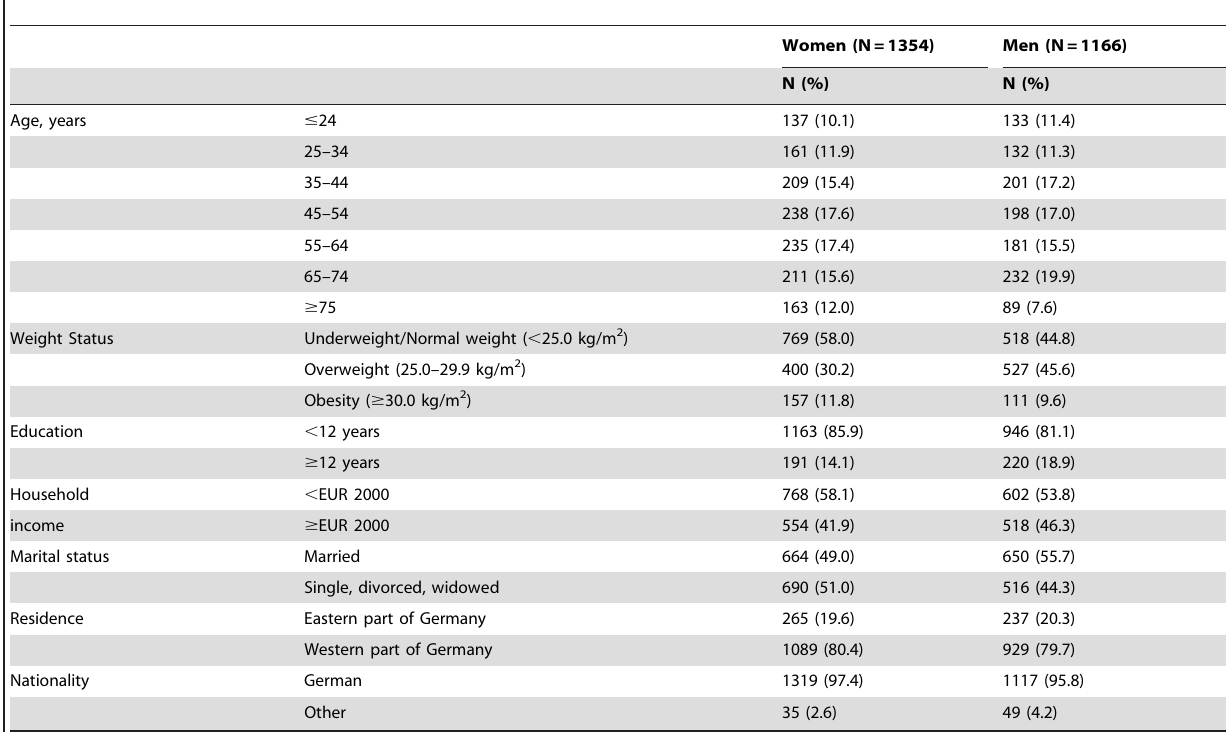
Table 1. Sociodemographic Characteristics (N=